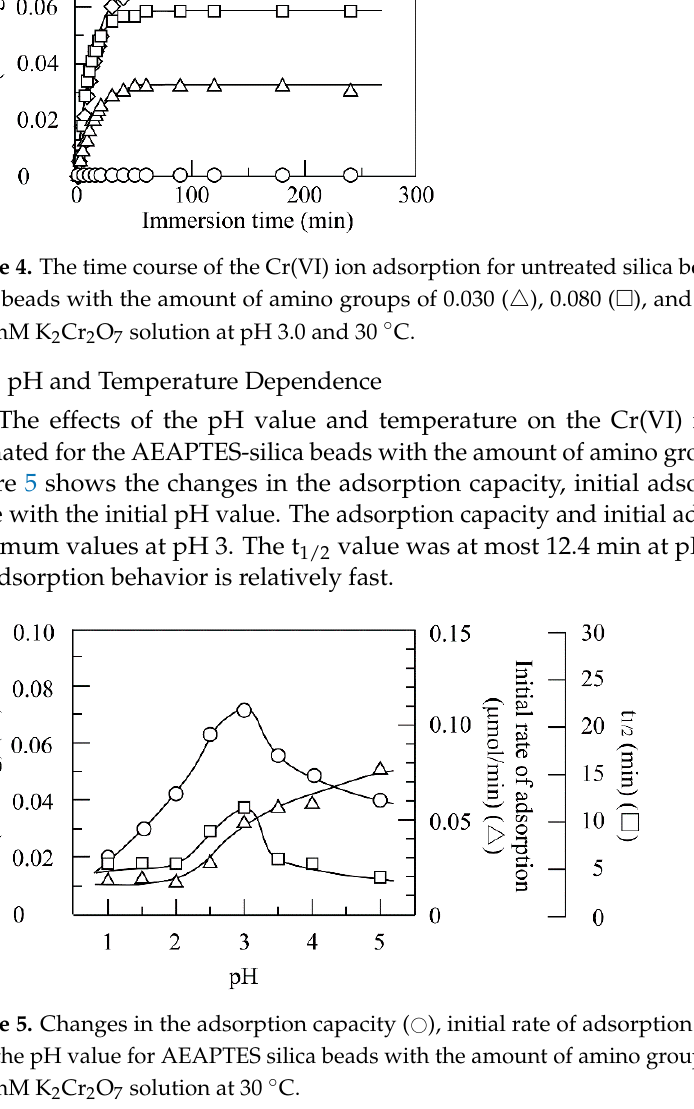
Figure 5. Changes in the adsorption capacity ( 〇 ), initial rate of adsorption ( △ ), and t 1/2 value ( □ ) with the pH value for AEAPTES silica beads with the amount of amino groups of 0.220 mmol/g in a 0.20 mM K 2 Cr 2 O 7 solution at 30 °C .